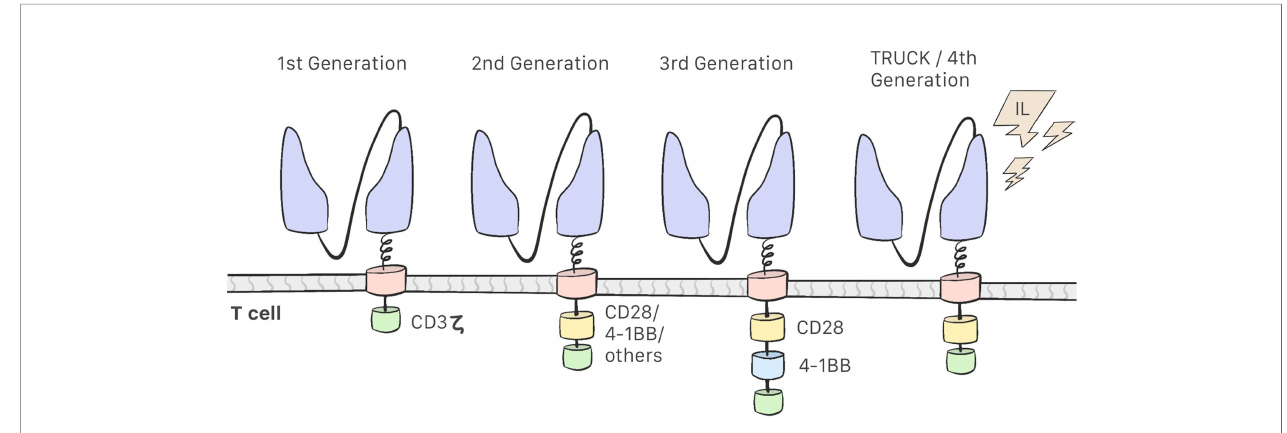
FIGURE 2 | First Generation CAR-T cells consist of a scFv region and the CD3 z intracellular domain. Second-generation CAR-T cells include a costimulatory molecules in the intracellular domain. Third-generation contains two costimulatory molecules. Fourth-generation CAR-T cell or TRUCKs secretes proin fl amatory